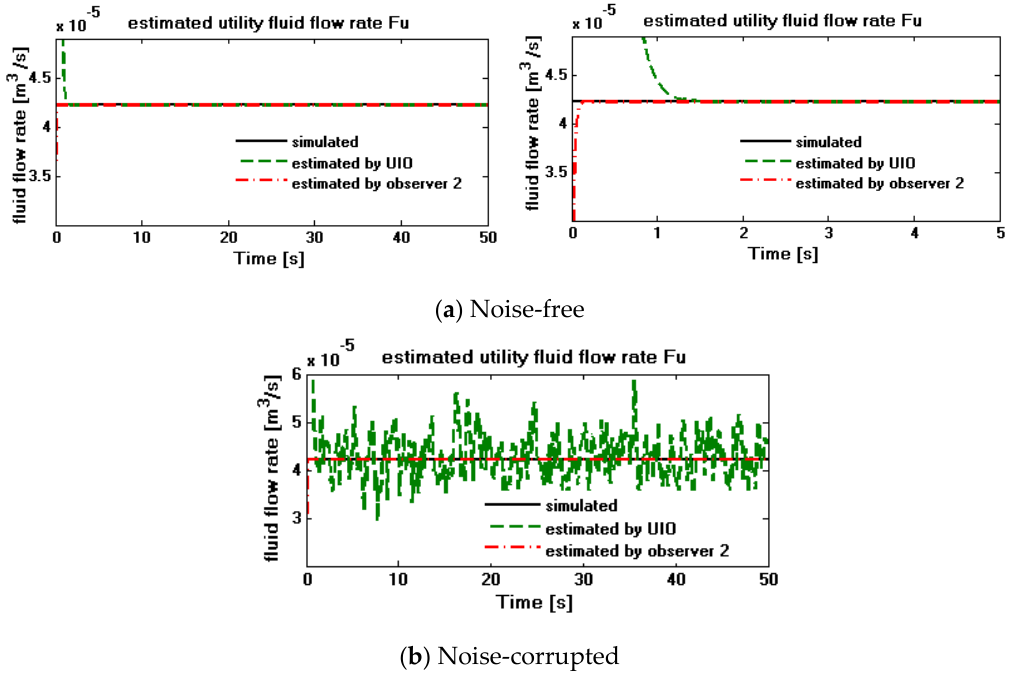
Figure 6. The computation and estimation of the utility fluid flow rate F u . The solid line is the computed value; the dashed line is estimated by the UIO; and the dashed, dotted line is estimated by Observer 2. ( a ) represents Noise-free case while ( b ) represents Noise-corrupted case.